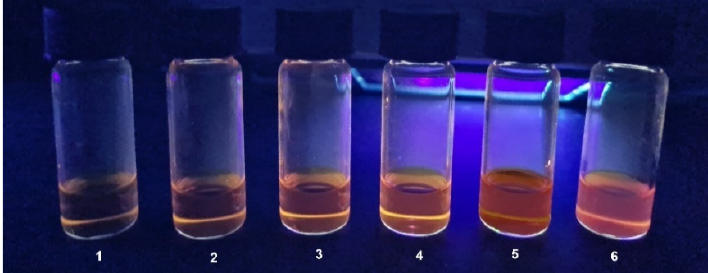
Figure 1. Above: emission CIE diagram of L and L 2 Zn in the solid phase. The samples used to record emission spectra and to calculate emission CIE coordinates are pictured in the insets. Below: absorption spectra (white curves) and emission spectra (red curves) of L and L 2 Zn in 0.1 mM TCE solution ( a , b ) and in the solid phase ( c , d ). Table 1. Absorption and emission properties of L and L 2 Zn in solutions and in the solid state.